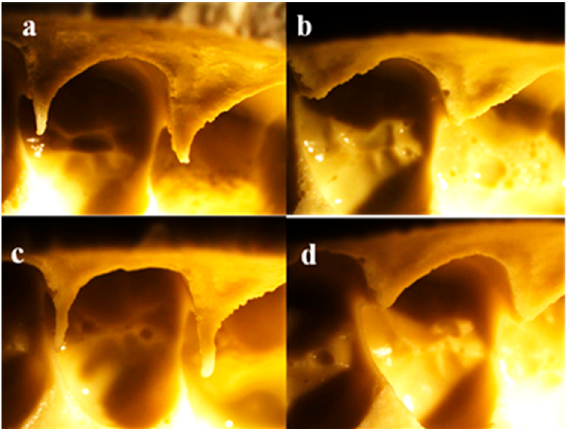
Figure 6. Stereomicroscopic images of clinical impression for patient with excessive proximal con- tact, magnification 10×: ( a ) Group 1 (Algistar mixed as Manufacturer), ( b ) Group 2 (Algistar with ↑ Powder/water ratio, ( c ) Group 3 (Tropicalgin with ↓ Powder/water ratio), ( d ) Group 4 (Tropical- gin mixed as Manufacturer).